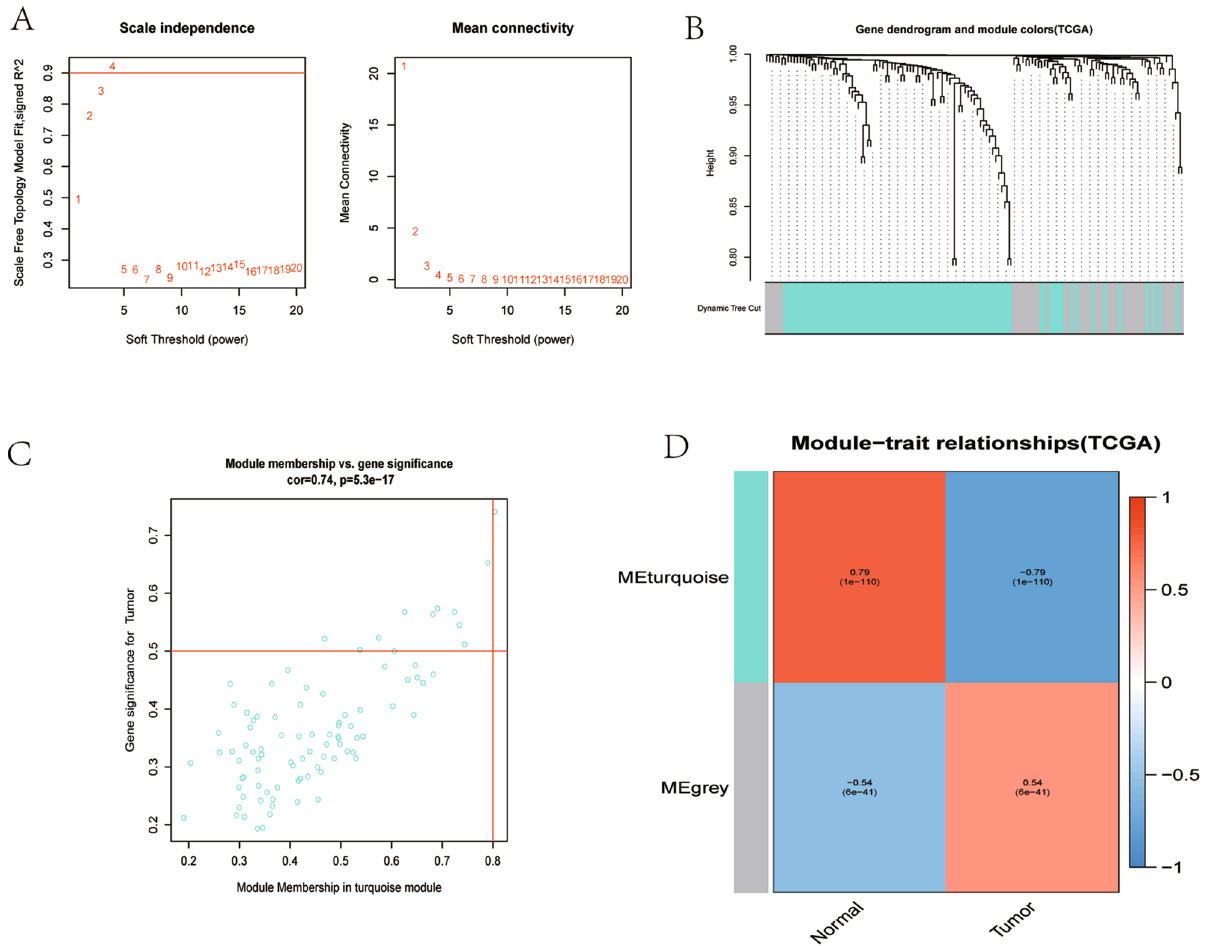
Figure 10. A weighted gene co-expression network analysis (WGCNA) of the DEGs. ( A ) A scaling factor beta determination based on the scale-free topology criterion. ( B ) Hierarchical clustering of genes in significant modules. The colors are assigned to each module by the Dynamic Tree Cut algorithm. ( C ) Scatterplot shows a highly significant correlation between gene significant (GS) versus module membership (MM) in the turquoise module with tumor. ( D ) Heatmap shows most significant and correlated module with tumor was blue